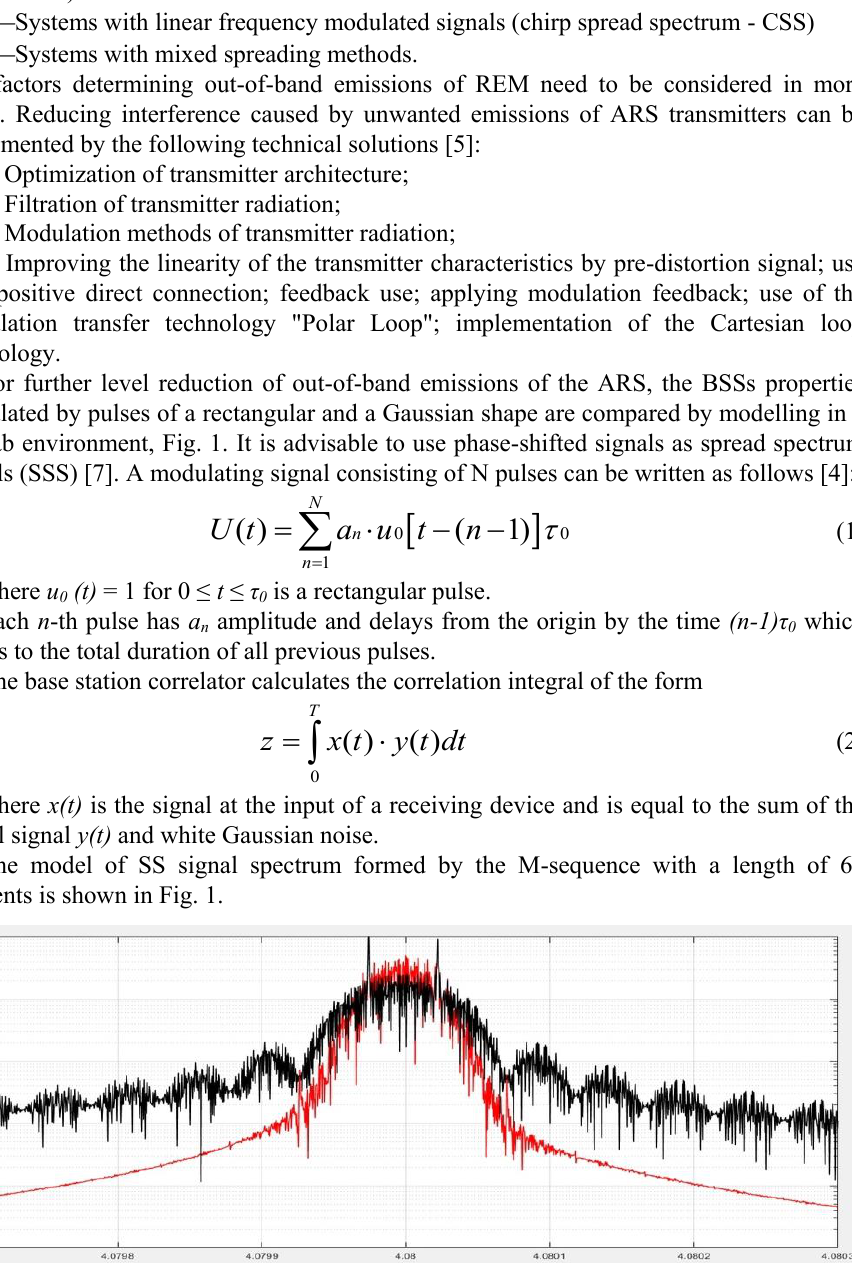
Fig. 1. Comparative image of the spectra of GFSK and FSK